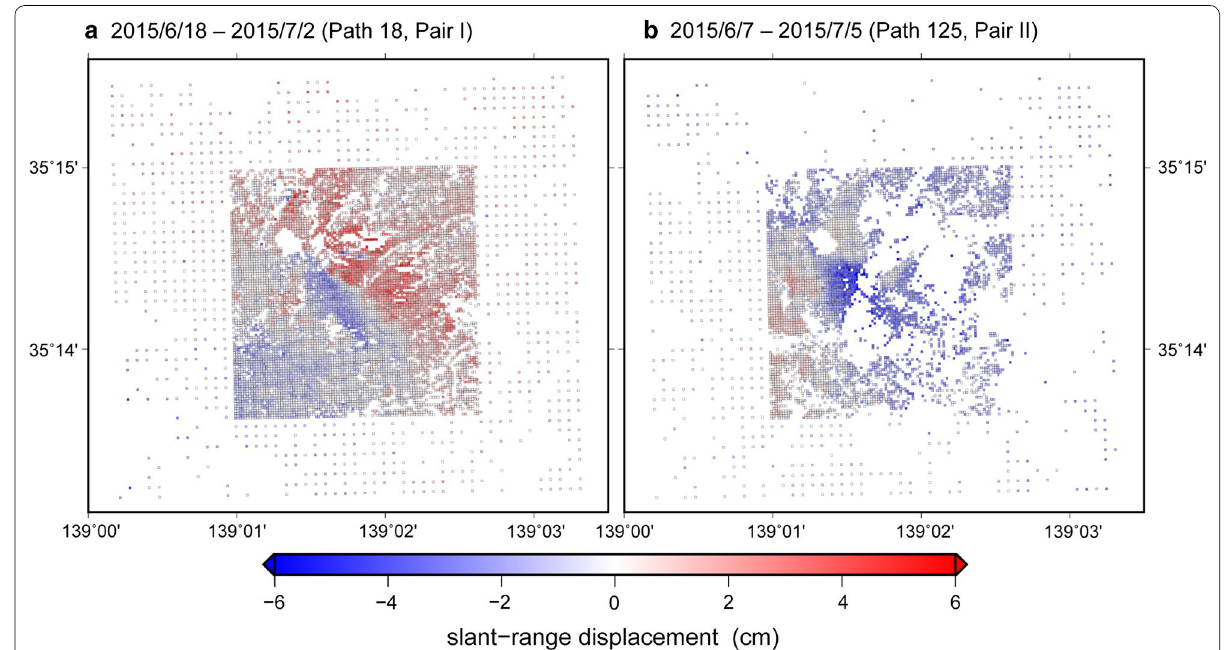
Table 2 Open crack parameters estimated from the first inversion (no reservoir at depth) Length (m) Width (m) Altitude a (m) Strike (°) Dip (°) East b (°) North b